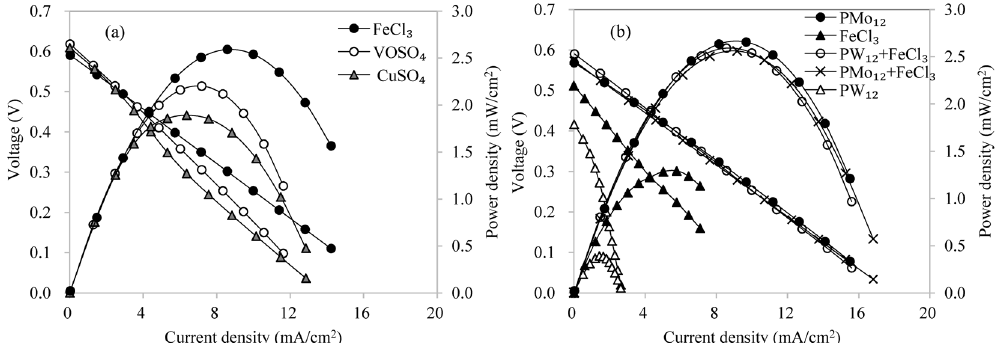
Figure 3. Performance of the LCFC using Lewis acid as co-catalyst ( a ) different Lewis acids; ( b ) combinations of FeCl 3 and PW 12 or PMo 12 ; the concentrations of glucose, phosphoric acid, Lewis acid, mono PW 12 and mono PMo 12 were 1.0, 1.5, 1.00, 0.30 and 0.30 mol/L, respectively, while the concentrations of PW 12 and PMo 12 were reduced to 0.06 and 0.03 mol/L, respectively, when combining with FeCl 3